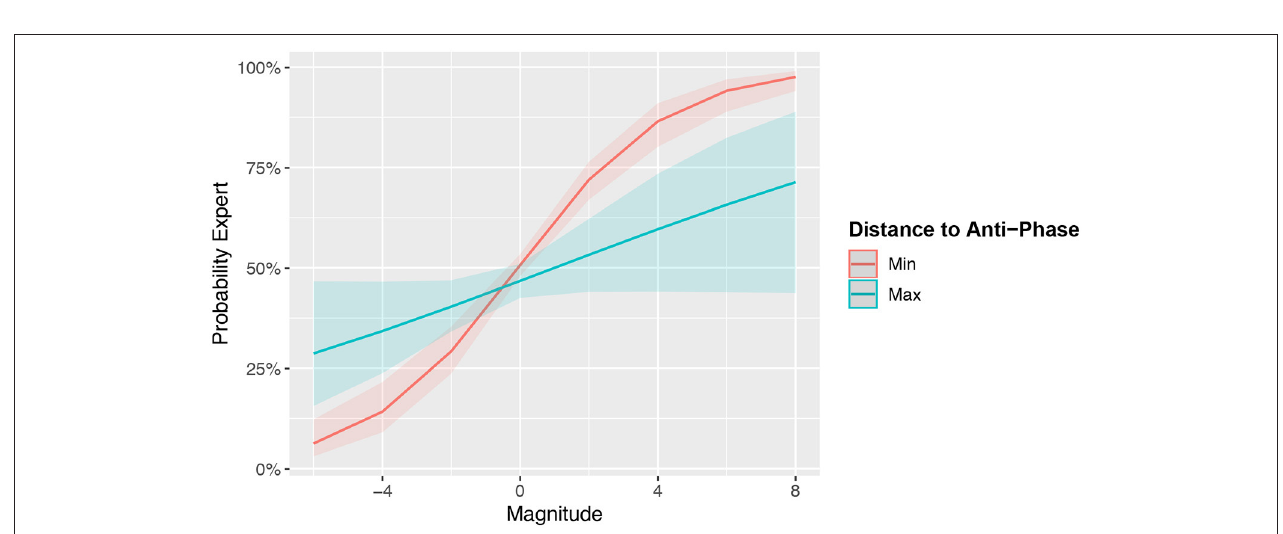
FIGURE 7 | Marginal effects plot the Magnitude and Distance to Anti-Phase interaction on the predicted probability that an observation belongs to an expert. The model attributes muscle activity toward anti-phase and stronger flexor compared to extensor activity to expert drummers. Bands represent 95% CIs.